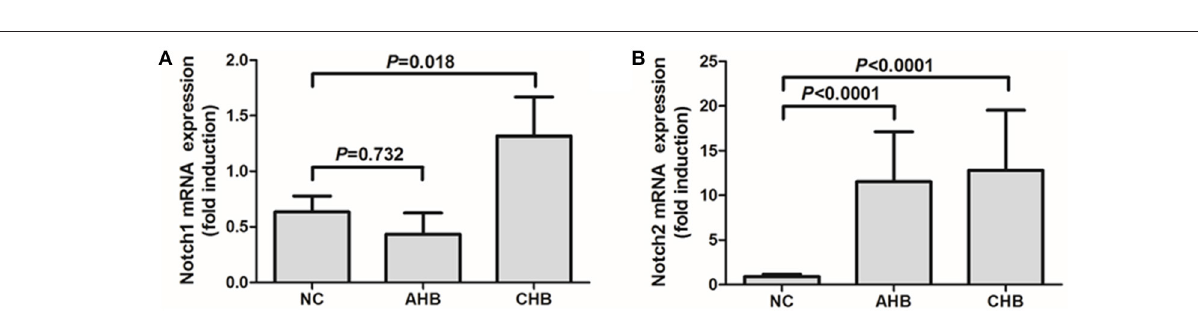
FIGURE 5 | Expressions of Notch1 and Notch2 were elevated in peripheral CD4 + T cells isolated from patients with HBV infection. mRNA expressions corresponding to Notch1 (A) and Notch2 (B) in CD4 + T cells were measured by PT-PCR. Results are displayed as fold differences relative to normal controls, and normalized to 18sRNA. All values are presented as the average from each group, and error bars represent